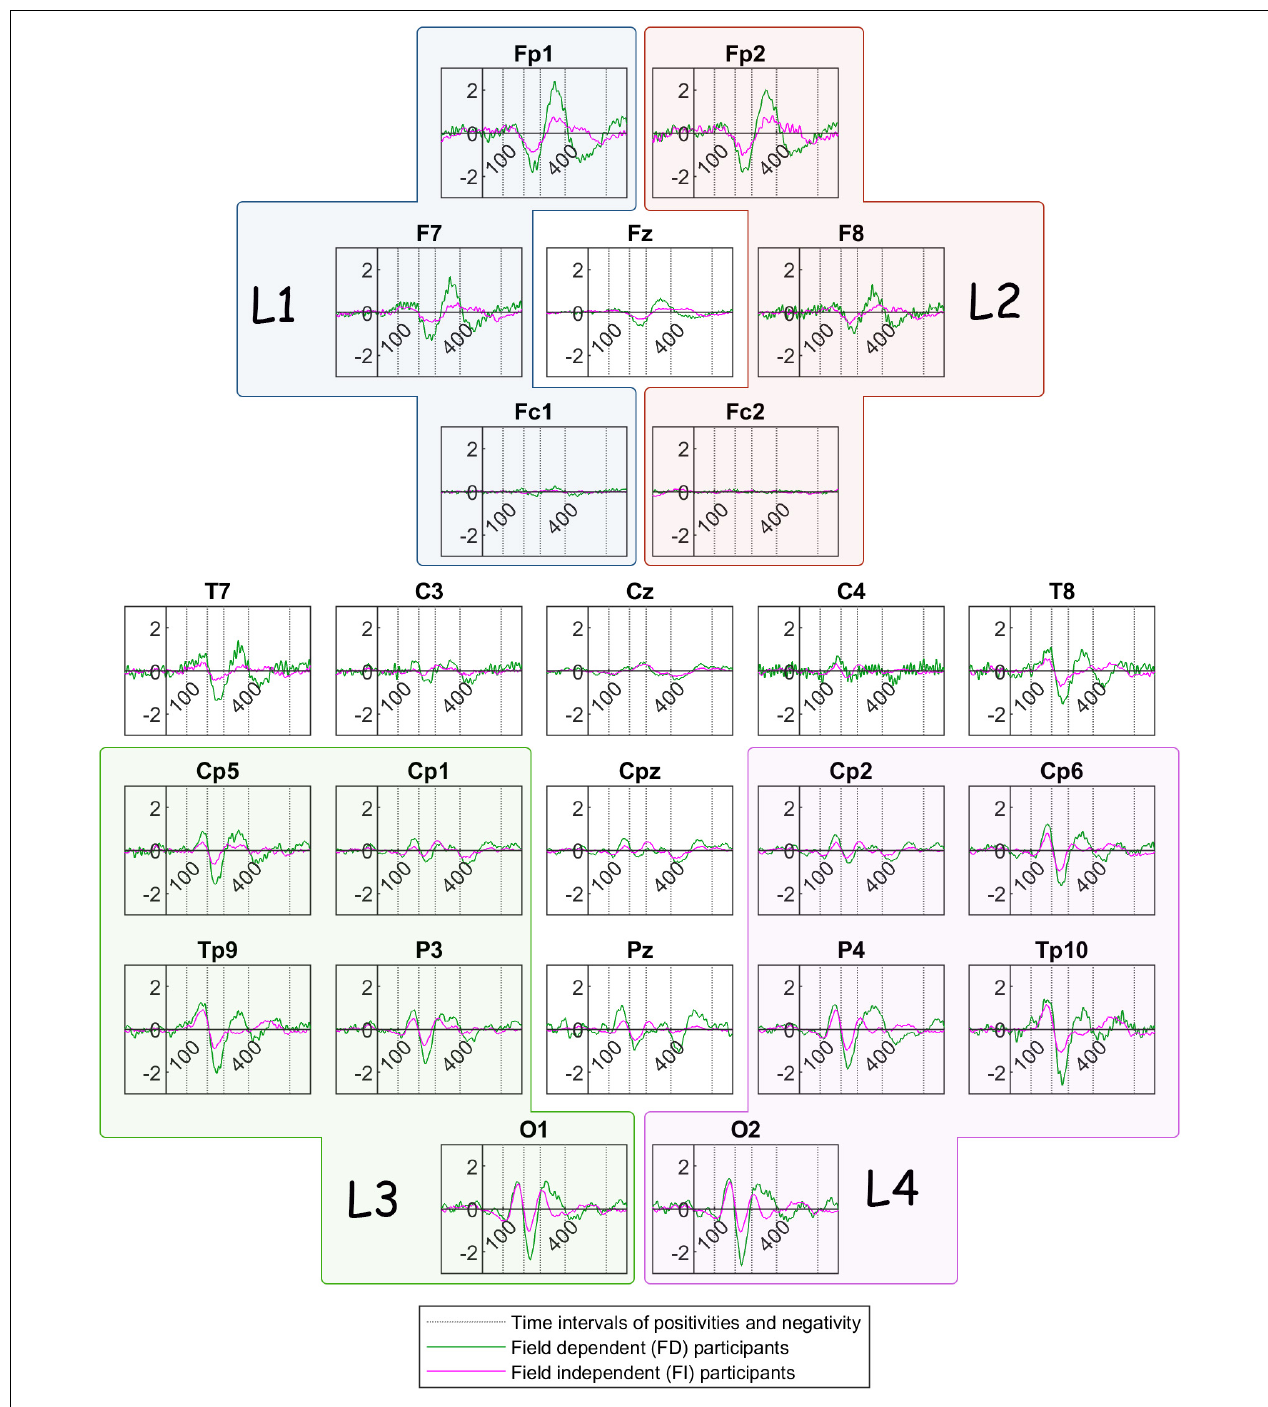
FIGURE 6 | Grand mean ERP traces across Field Dependent (FD) participants (green line) and Field Independent (FI) participants (magenta line). The dotted lines show the limits of the time interval for the features of the current: 100, 200, 280, 400, 600 ms. L1, L2, L3, and L4 are the group channels for the